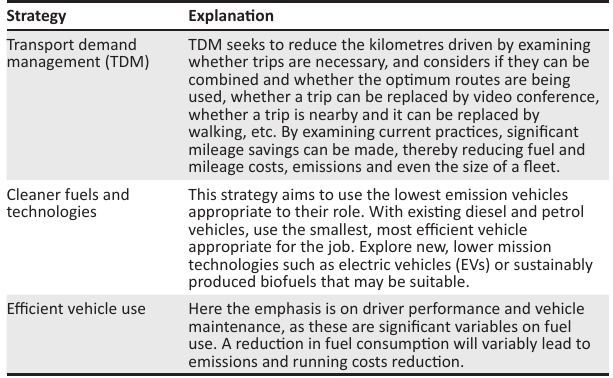
TABLE 2: Green fleet management